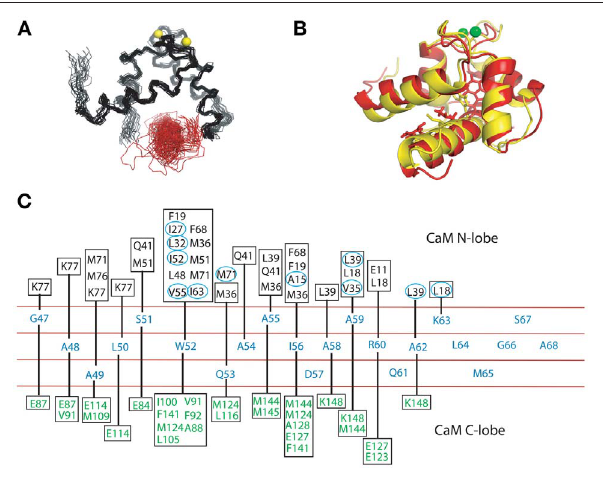
FIGURE 6 | (A) . Structure ensemble of the complex of the Ca 2 + /CaM NT and the NSCaTE motif (generated by HADDOCK 2.0). The colors used here are similar to those in Figure 4A . (B) Ribbon representation of the overlap of the calculated ( red ) and HADDOCK-generated ( yellow ) structures. (C) Contact residues between the CaM lobe (NT, calculated by CYANA 2.1, or CT, generated by HADDOCK 2.0) and the NSCaTE peptide ( < 4Å). The peptide is shown in the middle, and each residue is listed along the sequence. The contact residues from the N-lobe of CaM are listed above the peptide diagram. The residues with the actual NOE restraints used in the calculations are highlighted with blue circles . The contact residues from the C-lobe of CaM are listed below the peptide